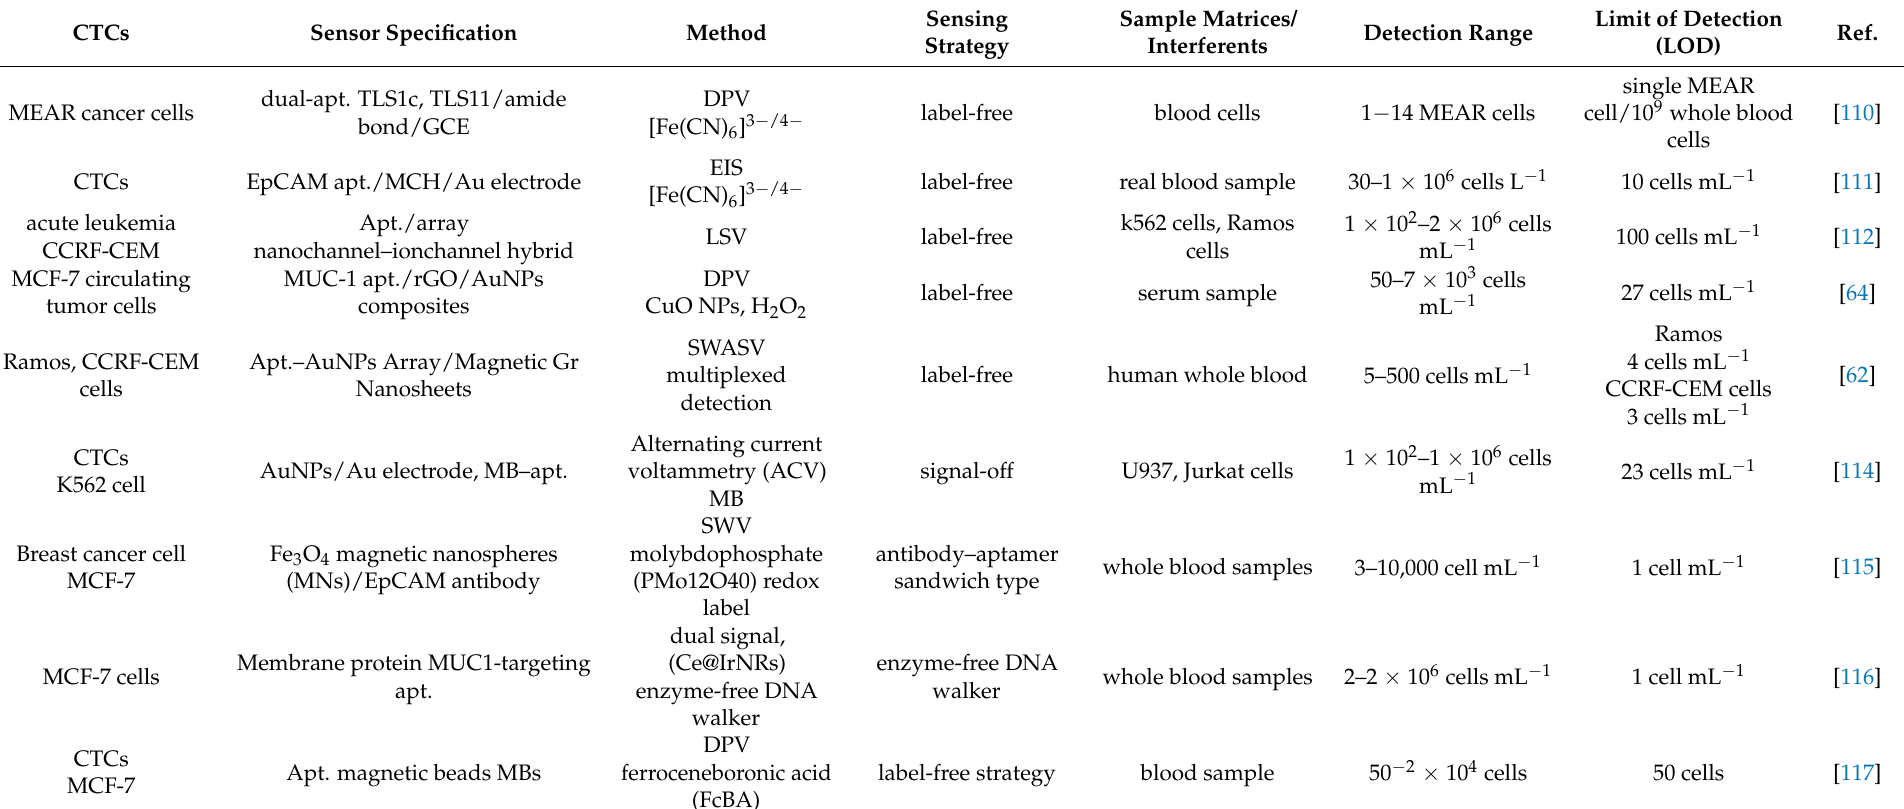
Table 4. Specifications and electrochemical performance of CTCs